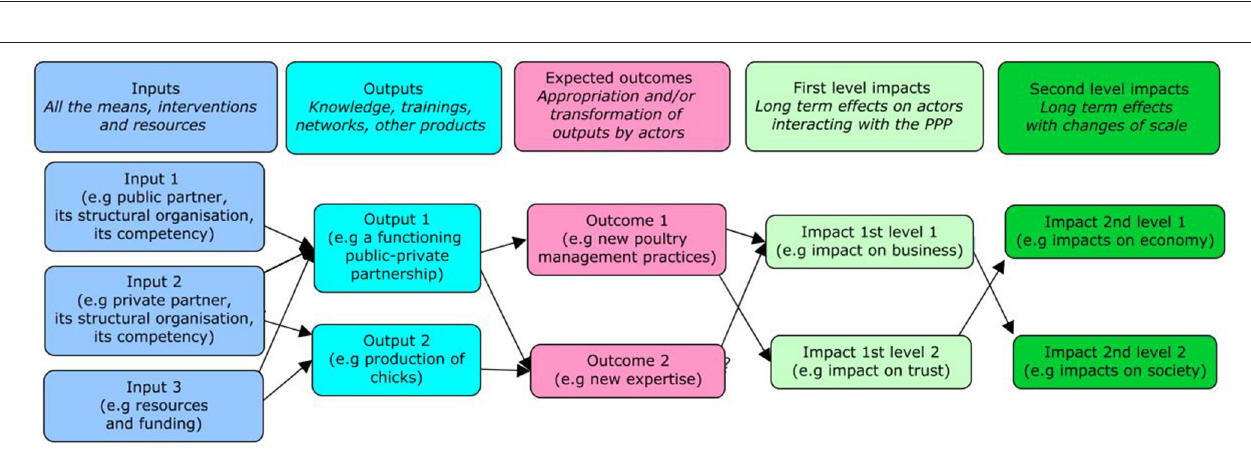
in the veterinary domain do not appear to be fully